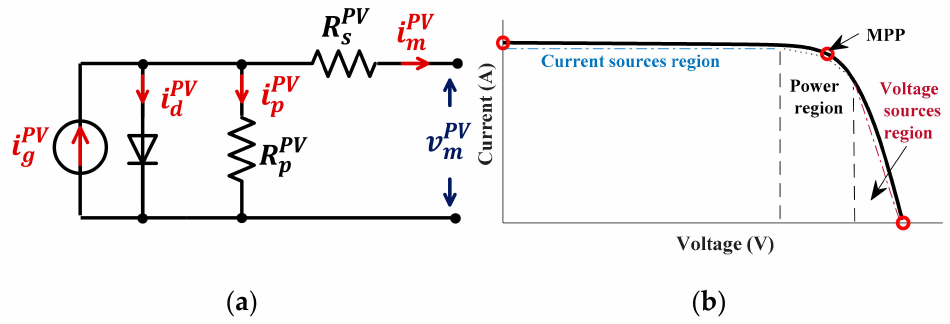
Figure 6. Solar PV cell ( a ) equivalent circuit based single-diode; ( b ) I-V characteristic